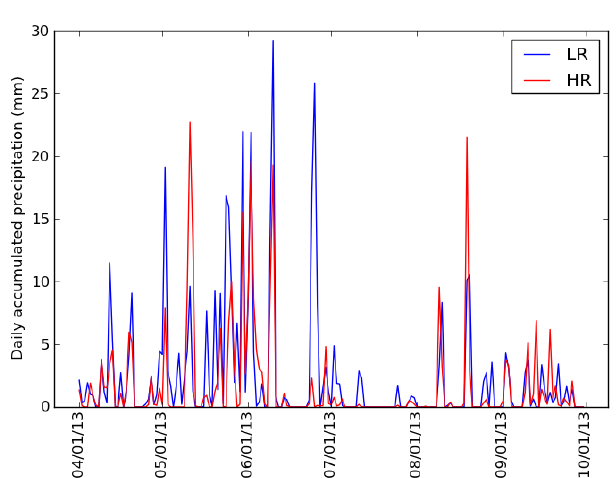
Figure 6. Daily MIN precipitation time series for the LR (blue) and HR (red) simulations in one LR grid cell located close to the center of the HR